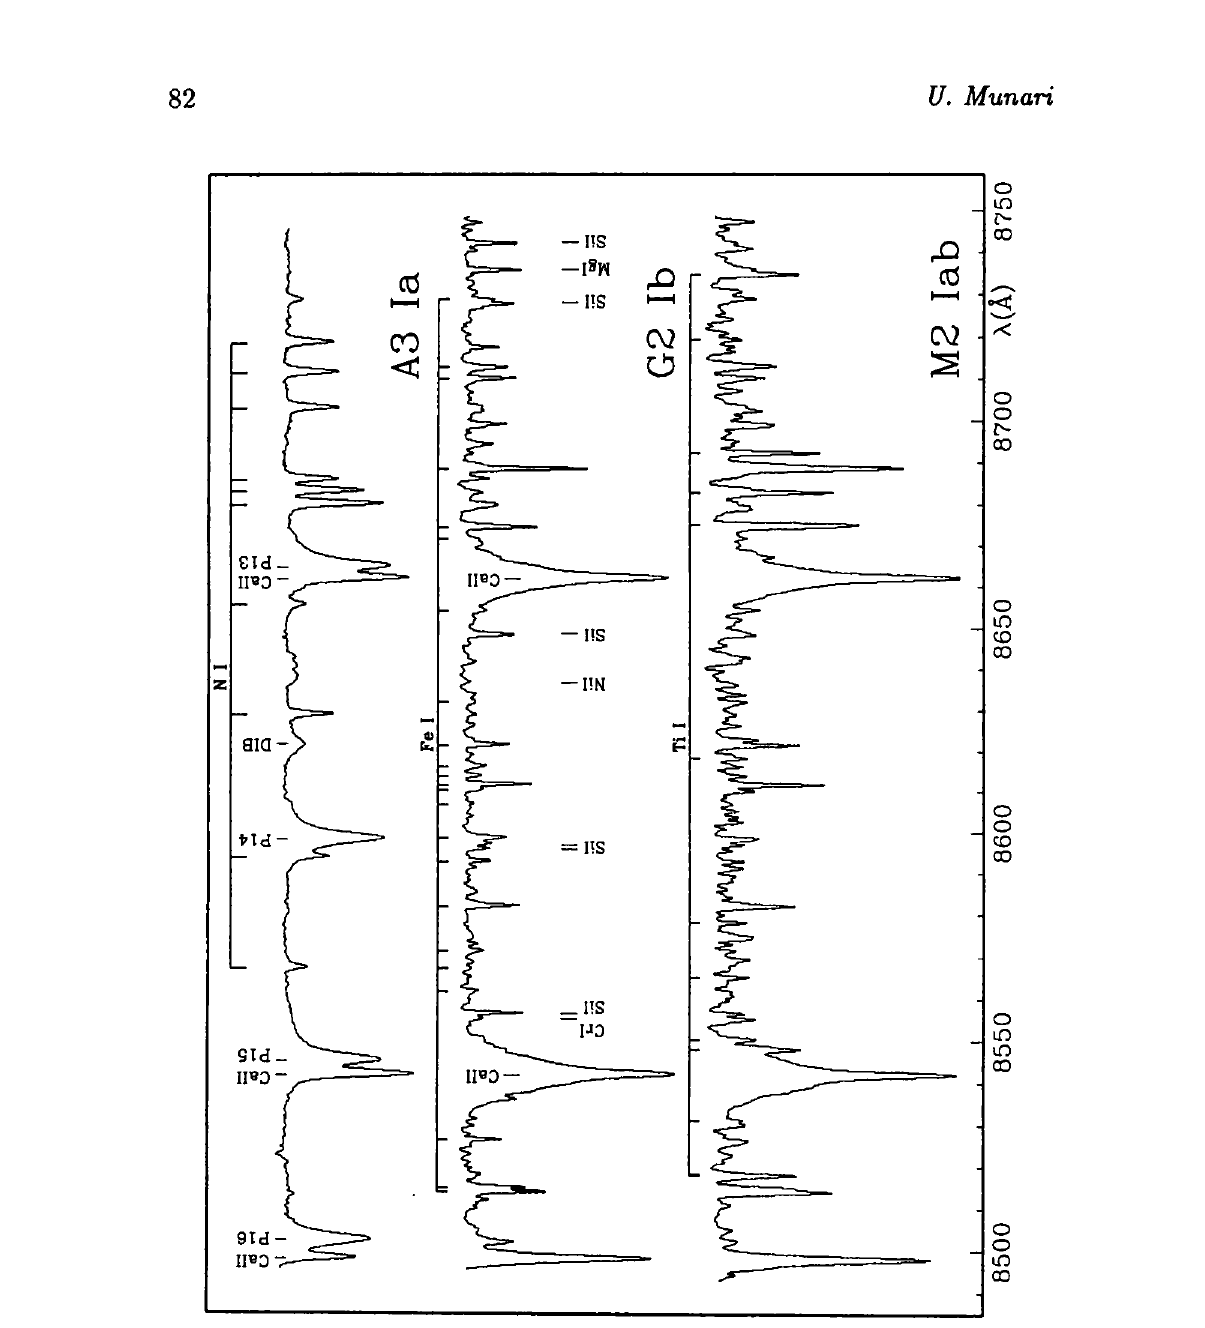
Fig. 3. Spectra of A, G and M supergiants with identification of some of the strongest lines. Sequences of NI, Fei and Til absorptions characterize the A, G and M spectra, respectively. Ca II lines become visible at B8 and dominate throughout the M stars, while the Paschen lines disappear at